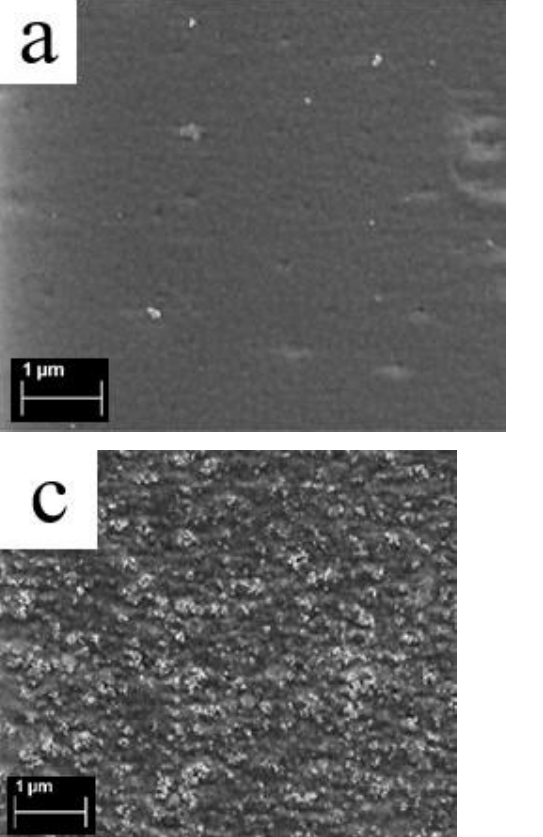
Figure 3. SEM images of the Aquivion ® -type membranes (EW = 890 g-eq/mol) with DND Z+: ( a ) 0% DND (without nanodiamonds); ( b ) 0.5 wt.% DND; and ( c , d ) 5 wt.% DND (different scales).